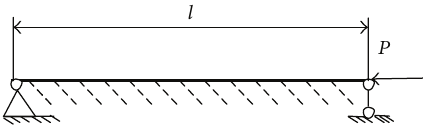
Figure 3: Rod lying on elastic